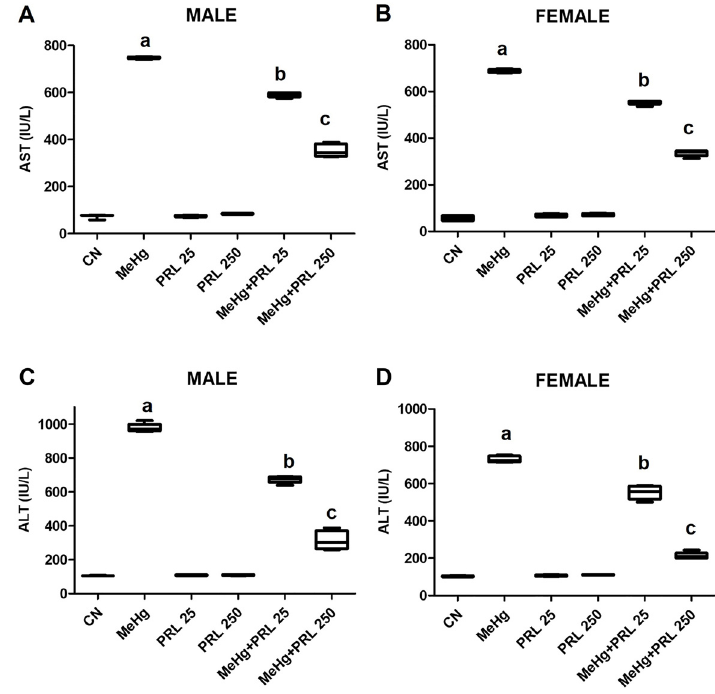
Figure 5. Hepatic markers in males ( A and C ) and females ( B and D ) of each treatment group. Data are reported as medians and interquartile range. a,b,c P o 0.01 compared to all other treatments (ANOVA with Tukey ’ s post-test). CN: control group; MeHg: methylmercury; PRL 25 and PRL 250: 25 and 250 m g/kg prolactin, respectively, every 12 h.